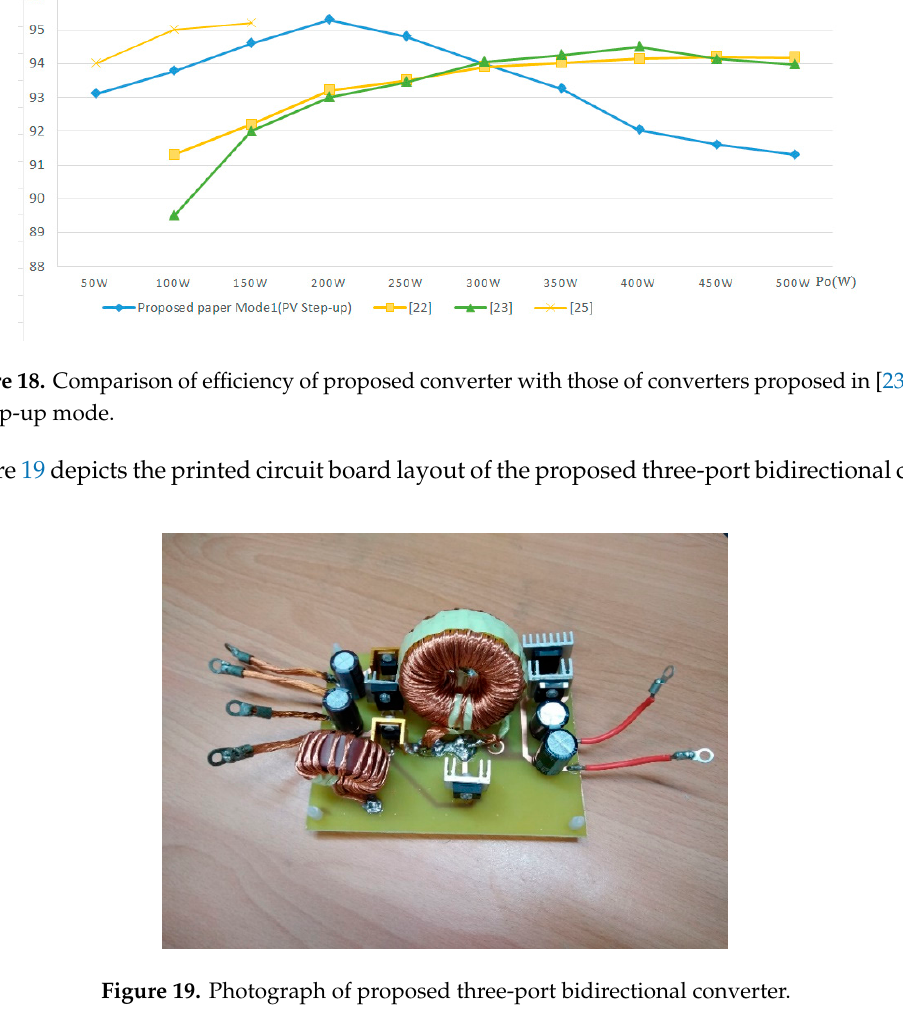
Figure 19. Photograph of proposed three-port bidirectional